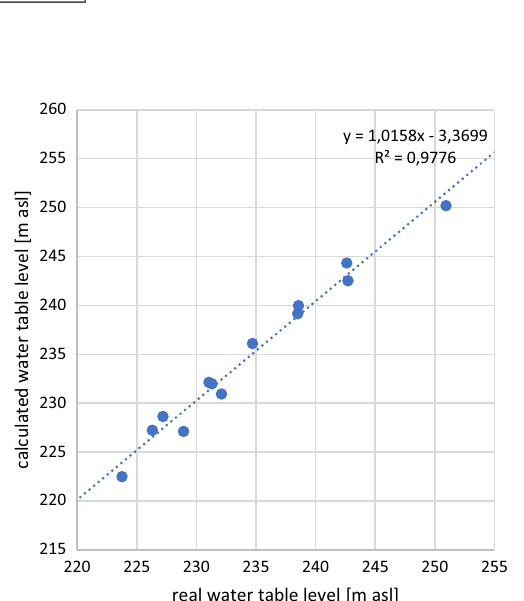
Fig. 4 Calibration chart of the numerical